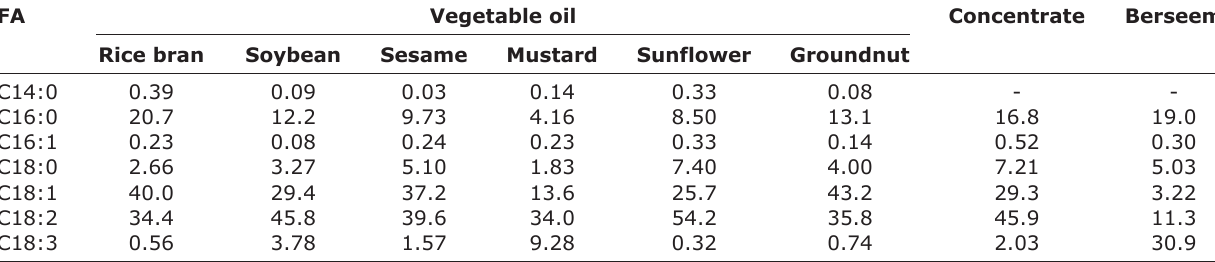
Table-1: FA composition of vegetable oils and substrate (g/100 g of total FAs). FA